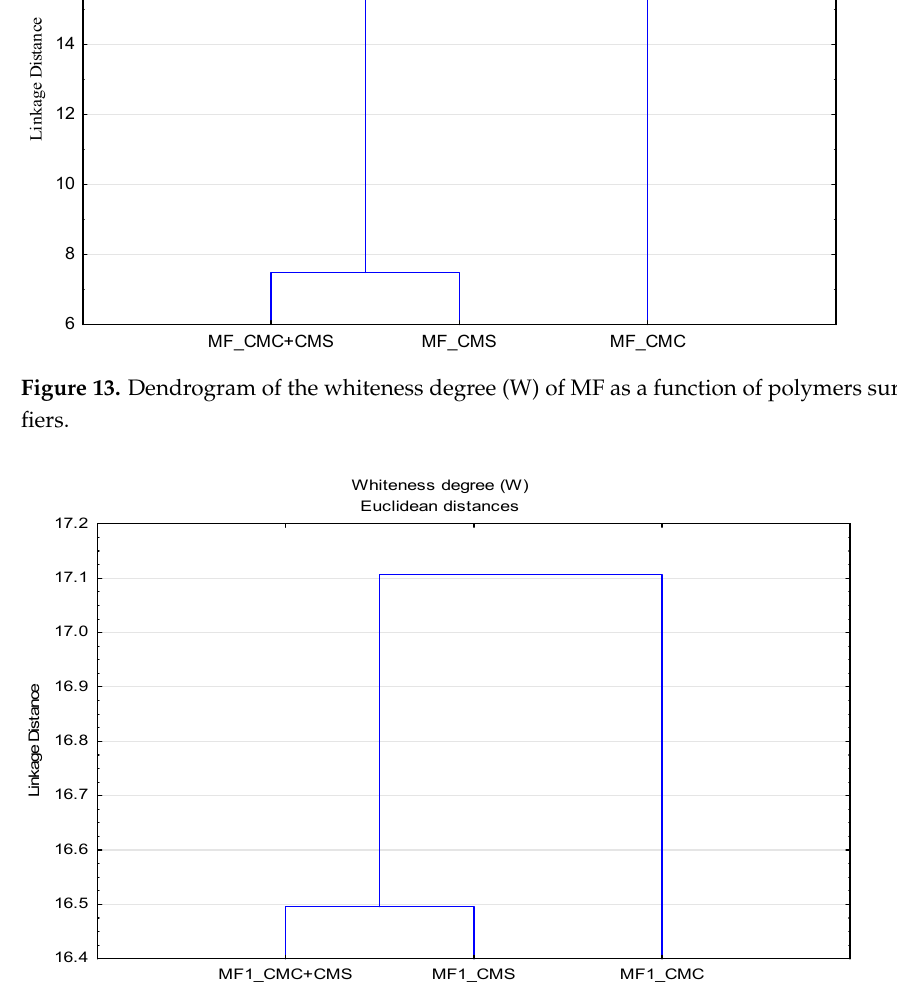
Figure 14. Dendrogram of the whiteness degree (W) of MF1 as a function of greying inhibition.